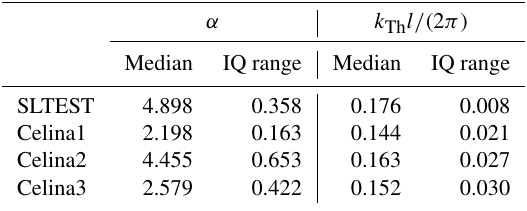
Table 3. Median and interquartile (IQ) values of the estimated order, α , and cutoff wavenumber, k Th , of the low-pass filter modeling the lidar spatial averaging for each